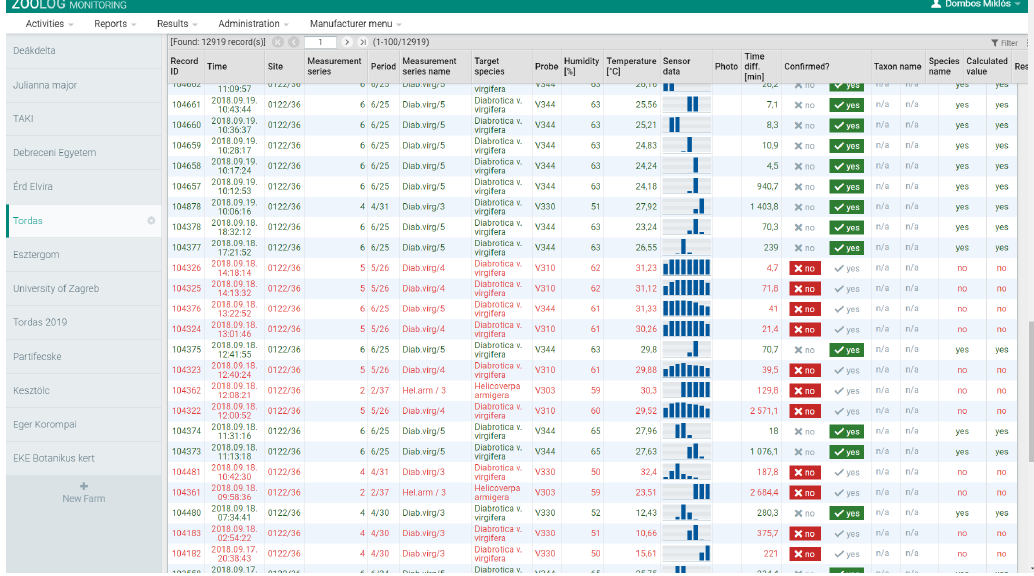
Figure 3. Filtering procedure for, and marking the records captured by, the ZooLog KLP probes. Each row corresponds to one detection. The sensor signal patterns are shown in the ‘Sensor data’ column. When only one or two signs were higher, we confirmed it manually in column ‘Confirmed?’ as “yes” (green colors) or “no” (red colors). We confirmed precisely the same number of detections that were captured in a given period. The patterns of positive detections differed significantly from the negative ones caused by other non-target insects. This procedure provided the learning dataset for deep-learning analysis used in filtering false detection data.